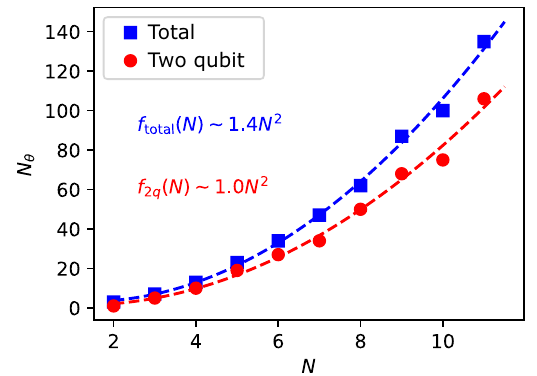
FIG. 5. Saturated number of variational parameters ( N θ ) as a function of LSM model size N . The total number of variational parameters for AVQDS simulations after saturation is reached (blue squares) grows quadratically with the number of sites N . The corresponding number of variational parameters associ- ated with two-qubit Pauli rotation gates (red dots) also shows quadratic scaling behavior ∝ N 2 , yet with a smaller